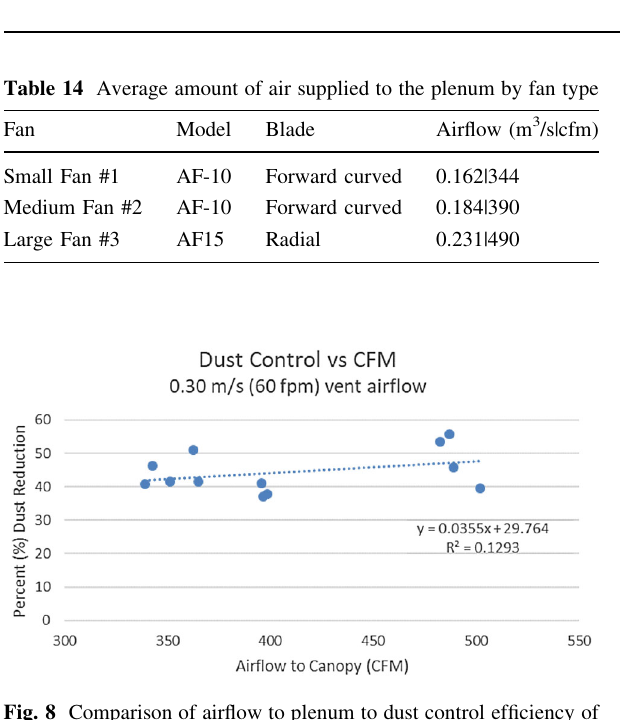
Fig. 8 Comparison of airflow to plenum to dust control efficiency of the CAC for the 60-fpm entry ventilation airflow